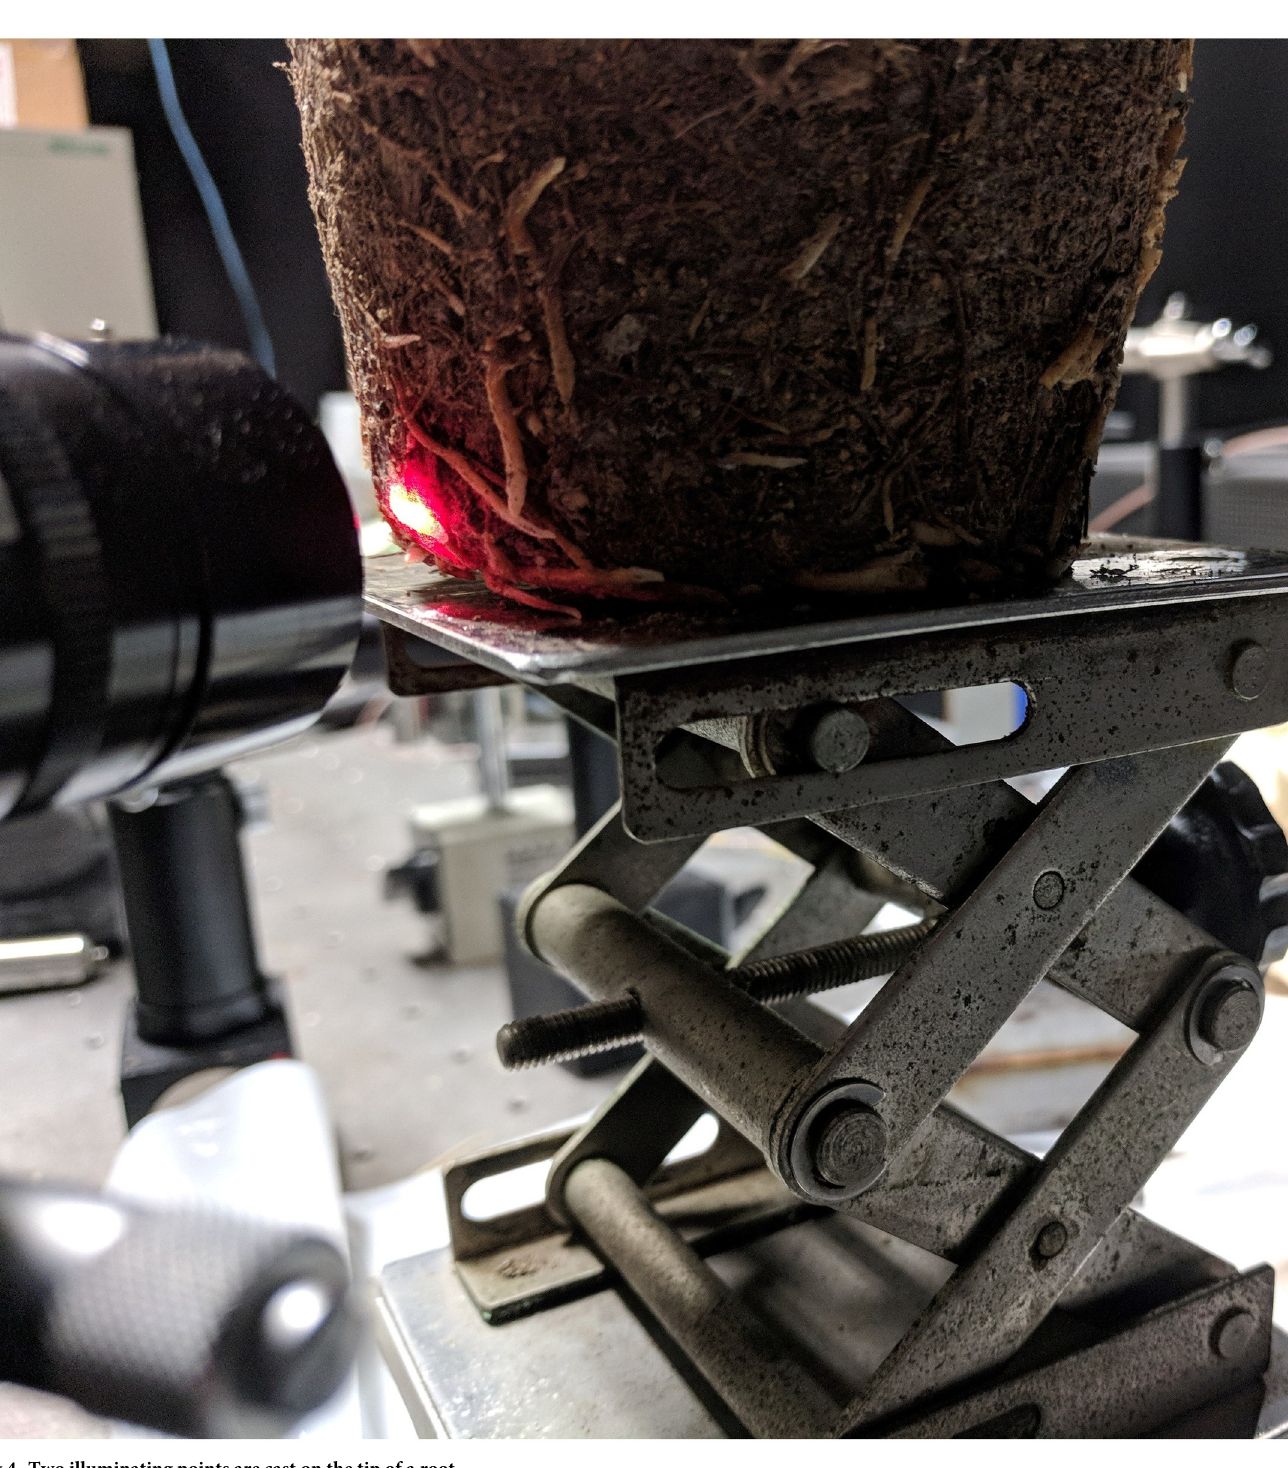
PLOS ONE | https://doi.org/10.1371/journal.pone.0234592 March 29,